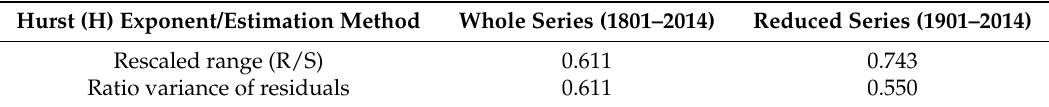
Table 1. Estimated values of the Hurst (H) exponent (with two methods) for the PDSI annual series as a whole and for a reduced number of